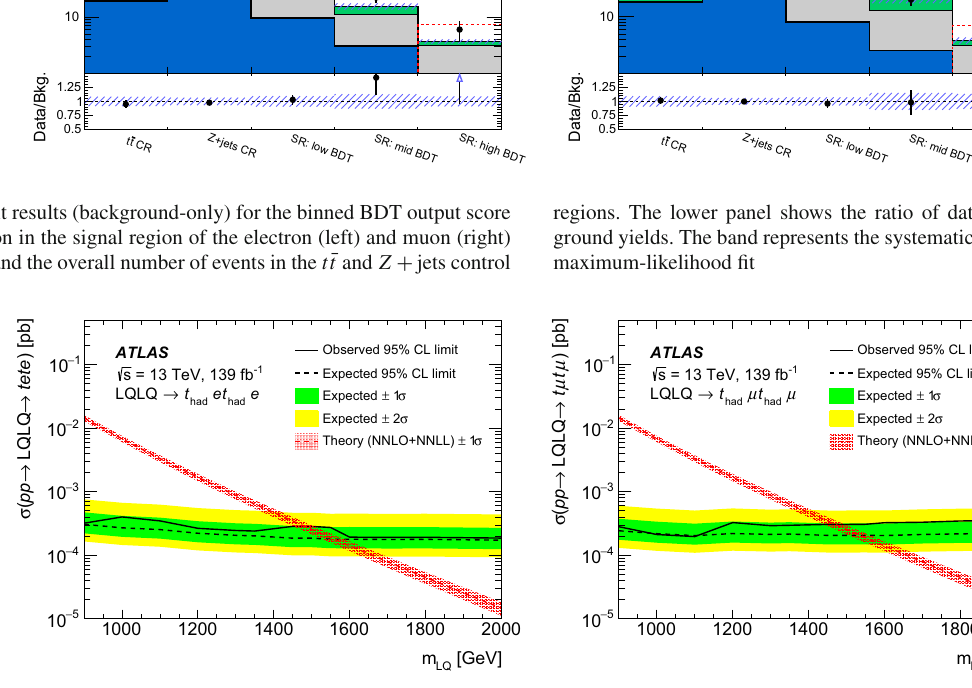
as a black dashed line. The green and yellow shaded bands correspond to ± 1 and ± 2 standard deviations, respectively, around the expected limit. The red curve and band show the nominal theoretical prediction and its ± 1 standard deviation uncertainty